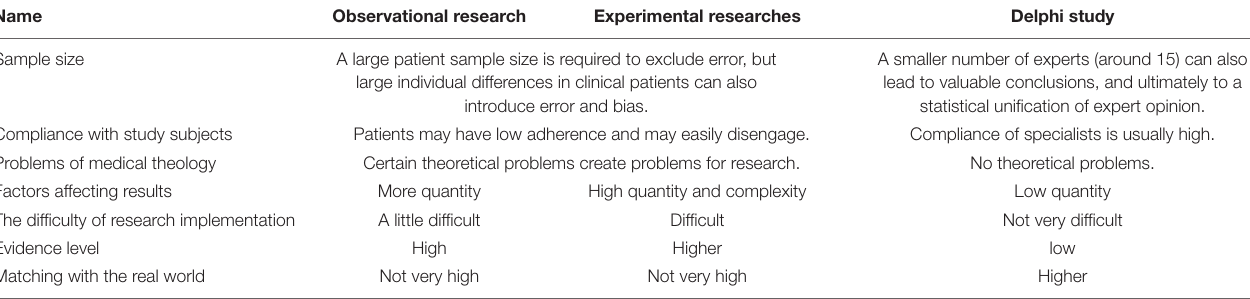
TABLE 1 | Advantages and disadvantages of the three